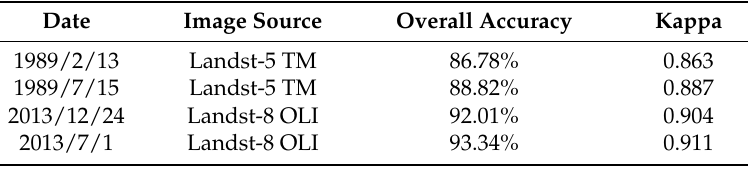
Table 3. Accuracy assessment of the land-cover classification results.